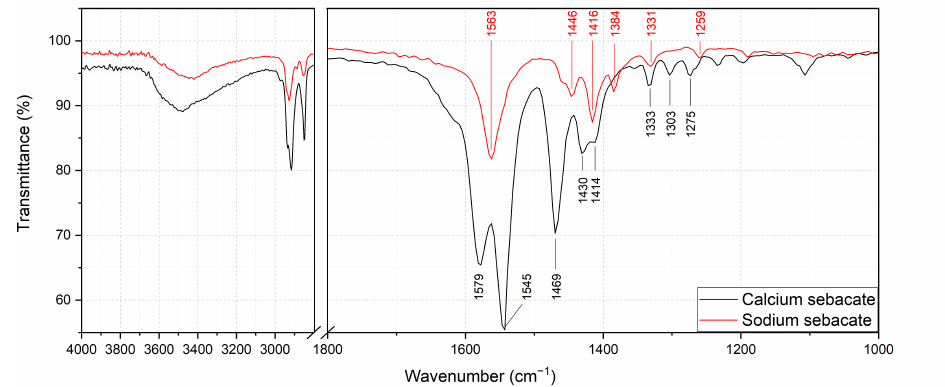
Figure 5. Transmission FT-Infrared spectra of calcium sebacate (black) and sodium (red)sebacate.